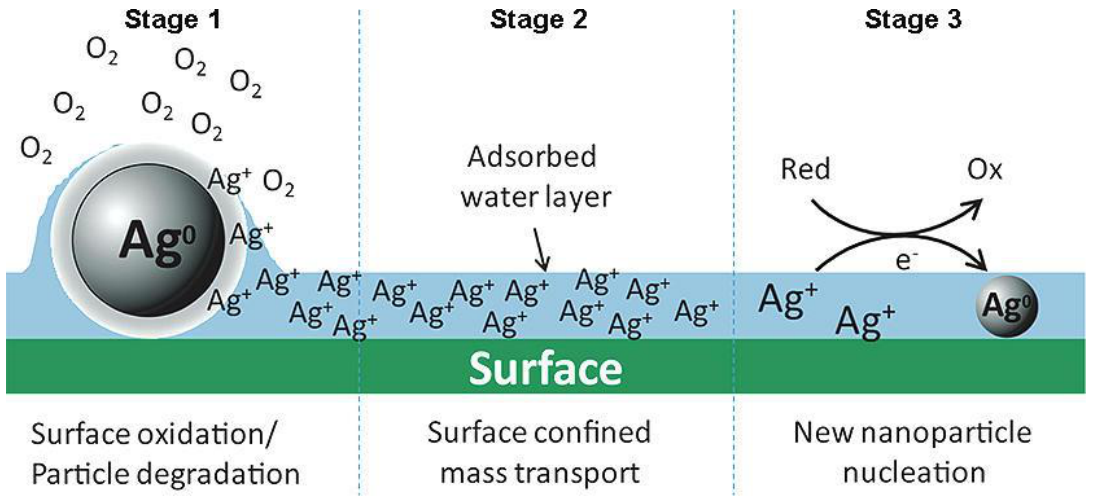
Figure 2. Proposed pathway for new particle formation from parent (nano)